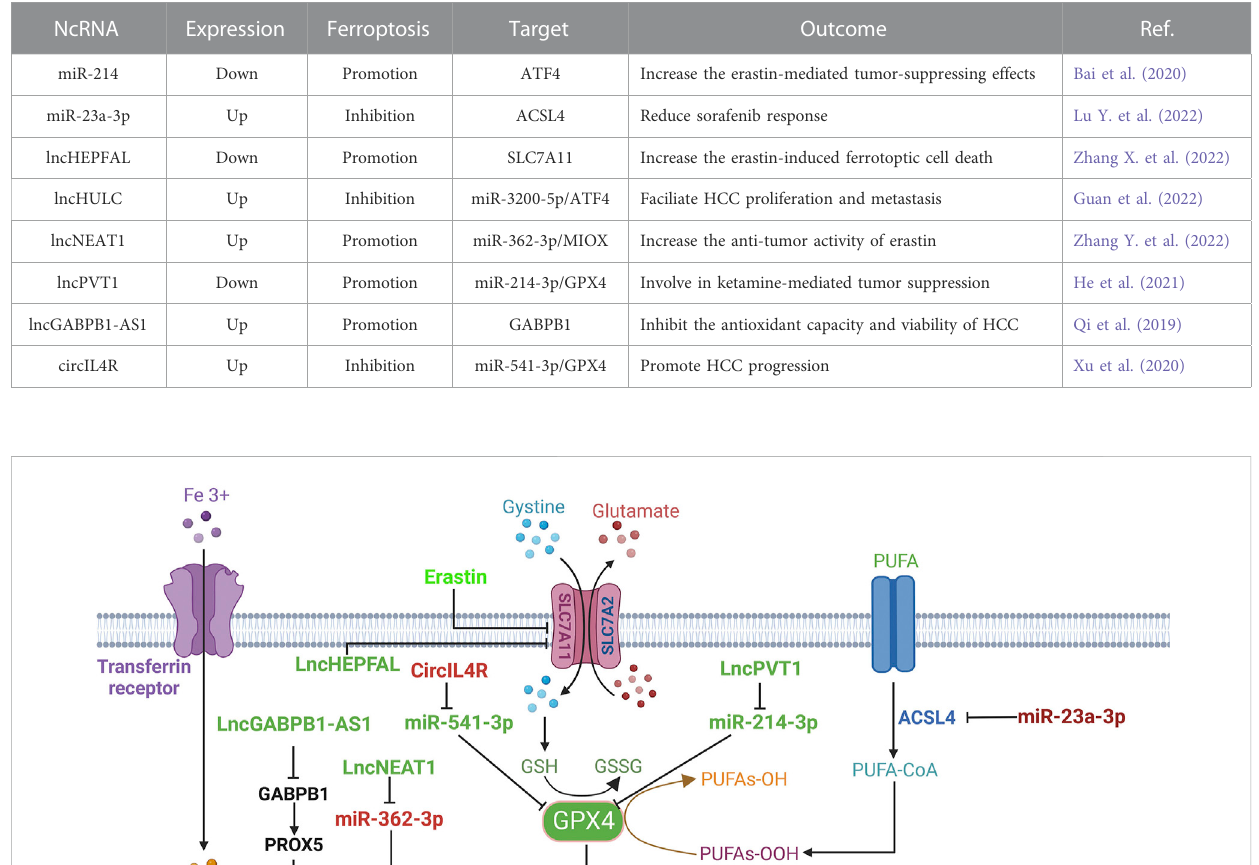
TABLE 2 Regulation of ncRNAs in ferroptosis of HCC.